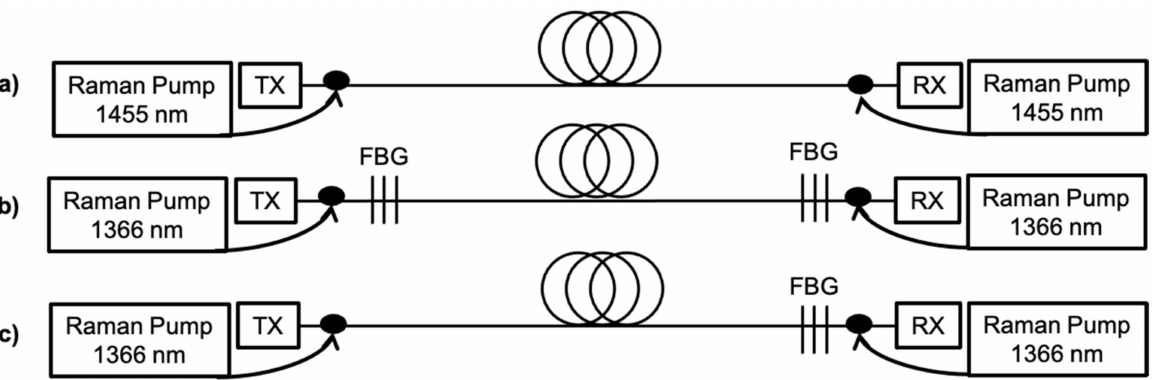
Figure 7. Schematic design of ( a ) first-order Raman, ( b ) second-order ultra-long fiber laser and ( c ) second-order random DFB Raman laser